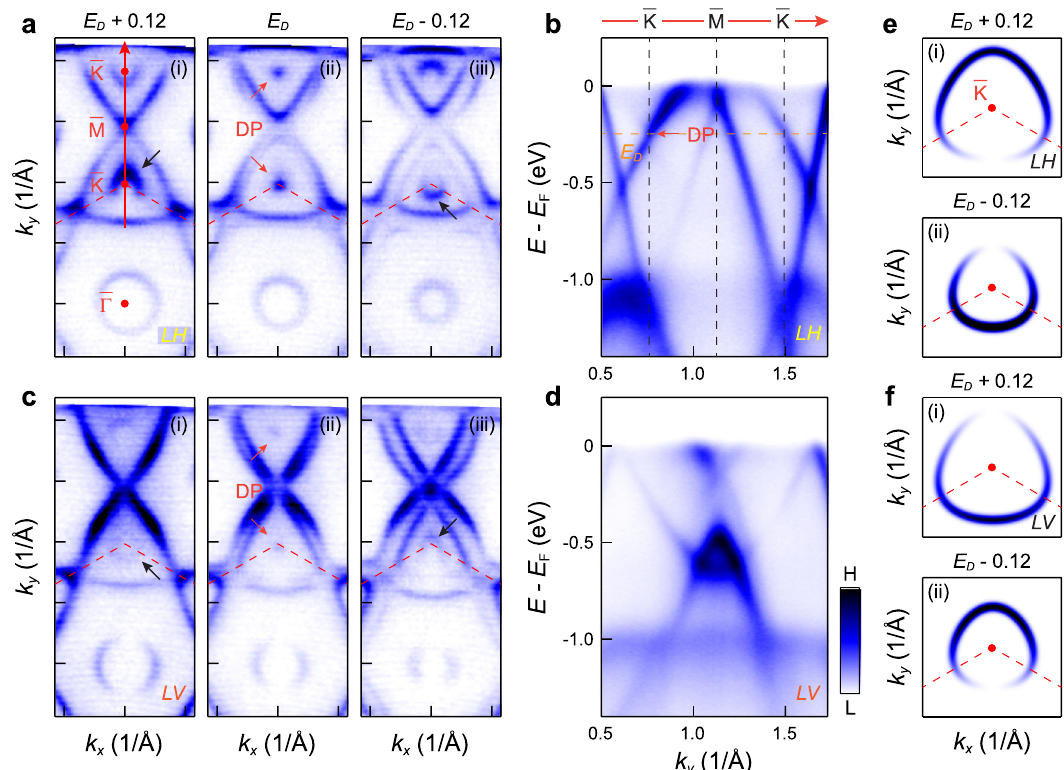
Fig. 4 Modulation of the photoemission intensity around the Dirac point in CsV 3 Sb 5 . a Constant energy maps above (i), at (ii) and below (iii) the Dirac cone, respectively. The black arrows indicate the spectra intensity pattern of the Dirac cone. b Experimental band dispersion along the (cid:1) K- (cid:1) M- (cid:1) K direction. The data in ( a ) and ( b ) were probed with LH polarization. c , d Same as ( a ),( b ), but measured with the LV polarization. All the experimental data ( a – d ) were obtained at 200 K. e Simulation of the constant energy map above (i) and below (ii) the Dirac cone for the LH polarization, based on the sublattice interference of kagome initial states. f Same as ( e) , but for the LV polarization. The red dashed lines in ( a , c ) and ( e , f ) show the Brillouin